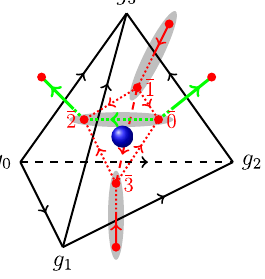
FIG. 3. Fermionic degrees of freedom in a tetrahedron. The red dots represent Majorana fermions on the two sides of each triangle. The blue ball represents the complex fermion of the (special) group supercohomology model at the center of the tetrahedron. The green line is the decorated Kitaev ’ s Majorana chain on the dual lattice P